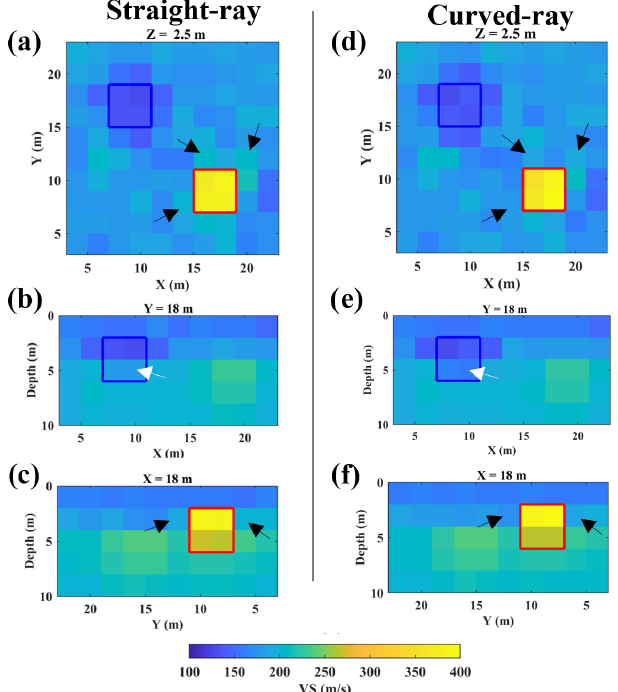
Figure 4. The VS models from SWT inversion. Straight-ray SWT results are shown at: (a) 2.5m depth, (b) Y = 18m, (c) X = 18m, and the results of the curved-ray for the same slices are displayed at panels (d) – (f) . The boundaries of the low-velocity and high-velocity blocks are superimposed in blue and red. The black and white ar- rows mark the blocks in which the curved-ray approach provides better results.